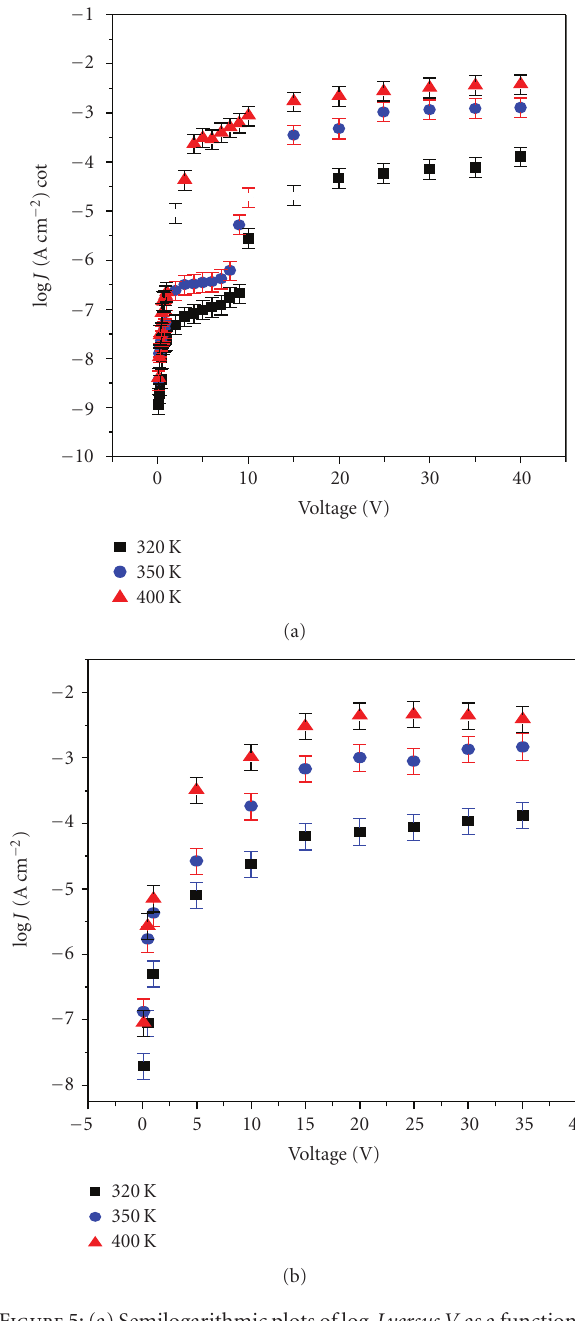
Figure 5: (a) Semilogarithmic plots of log J versus V as a function of poling temperature in the forward bias regime. (b) Semilogarithmic plots of log J versus V as a function of poling temperature in the reverse bias